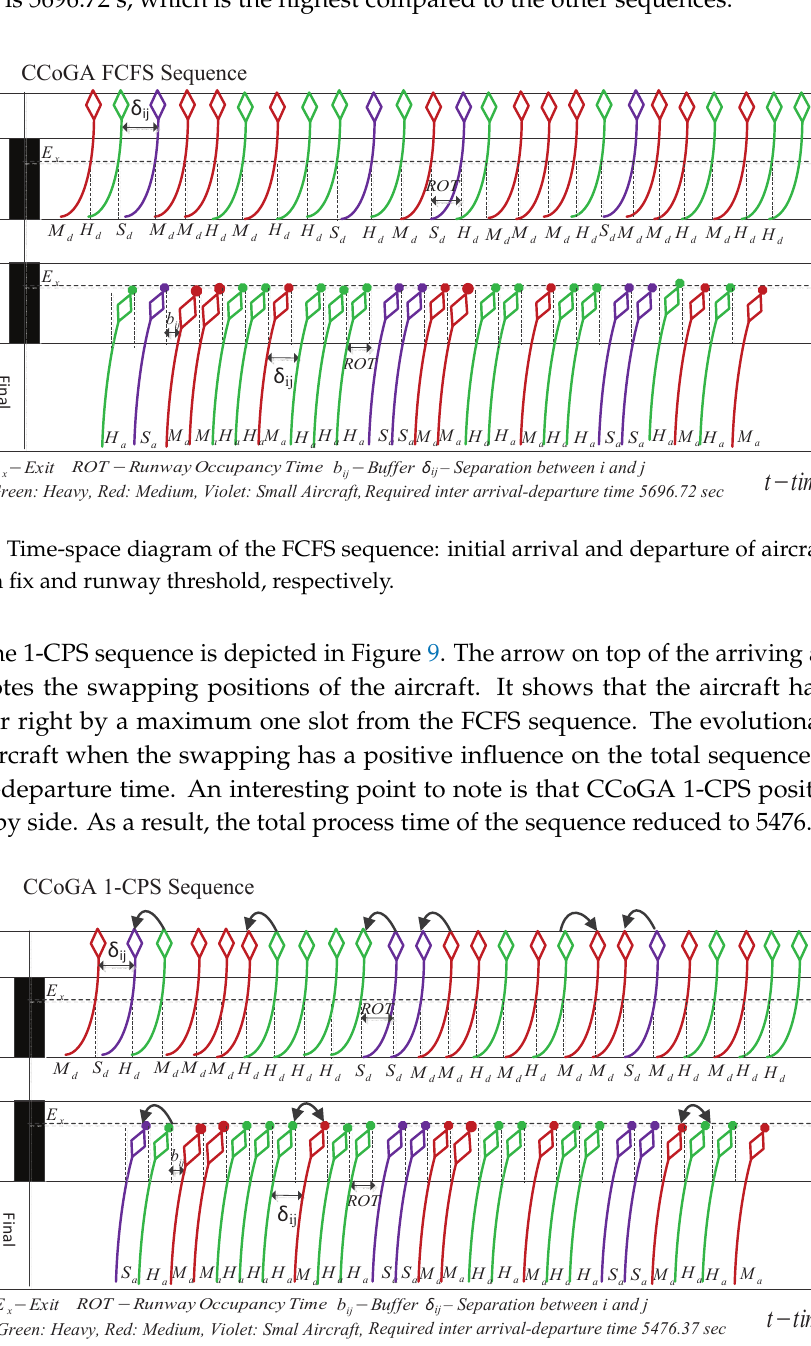
Figure 9. Time-space diagram of the CCoGA 1-CPS sequence: a flight can shift its position either one position left or one position right from the FCFS